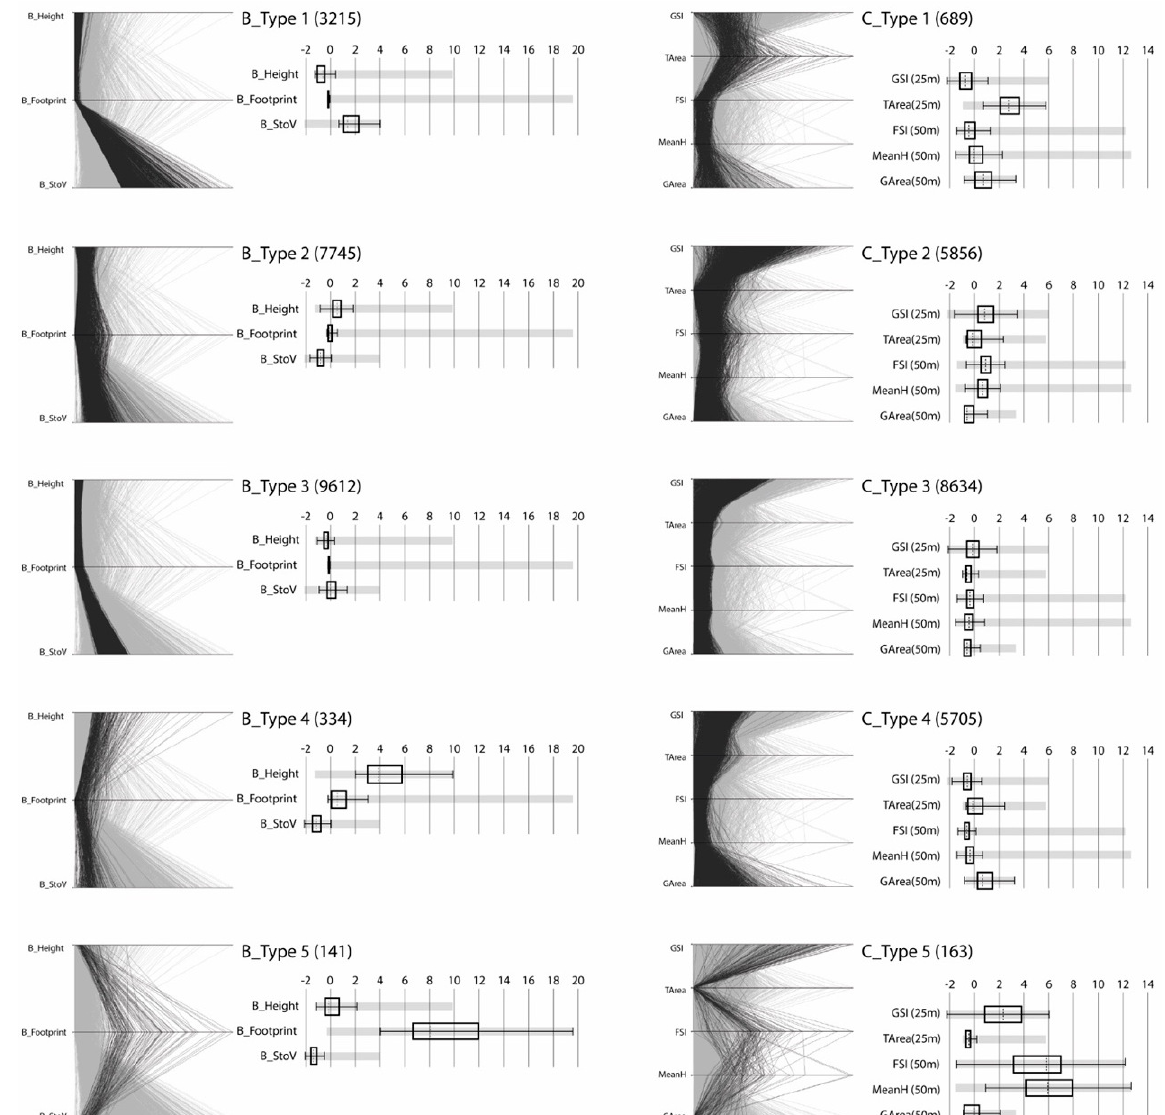
Figure 3. Standardised (z‐score) numerical profiles of the building types (left column) and context types (right column).